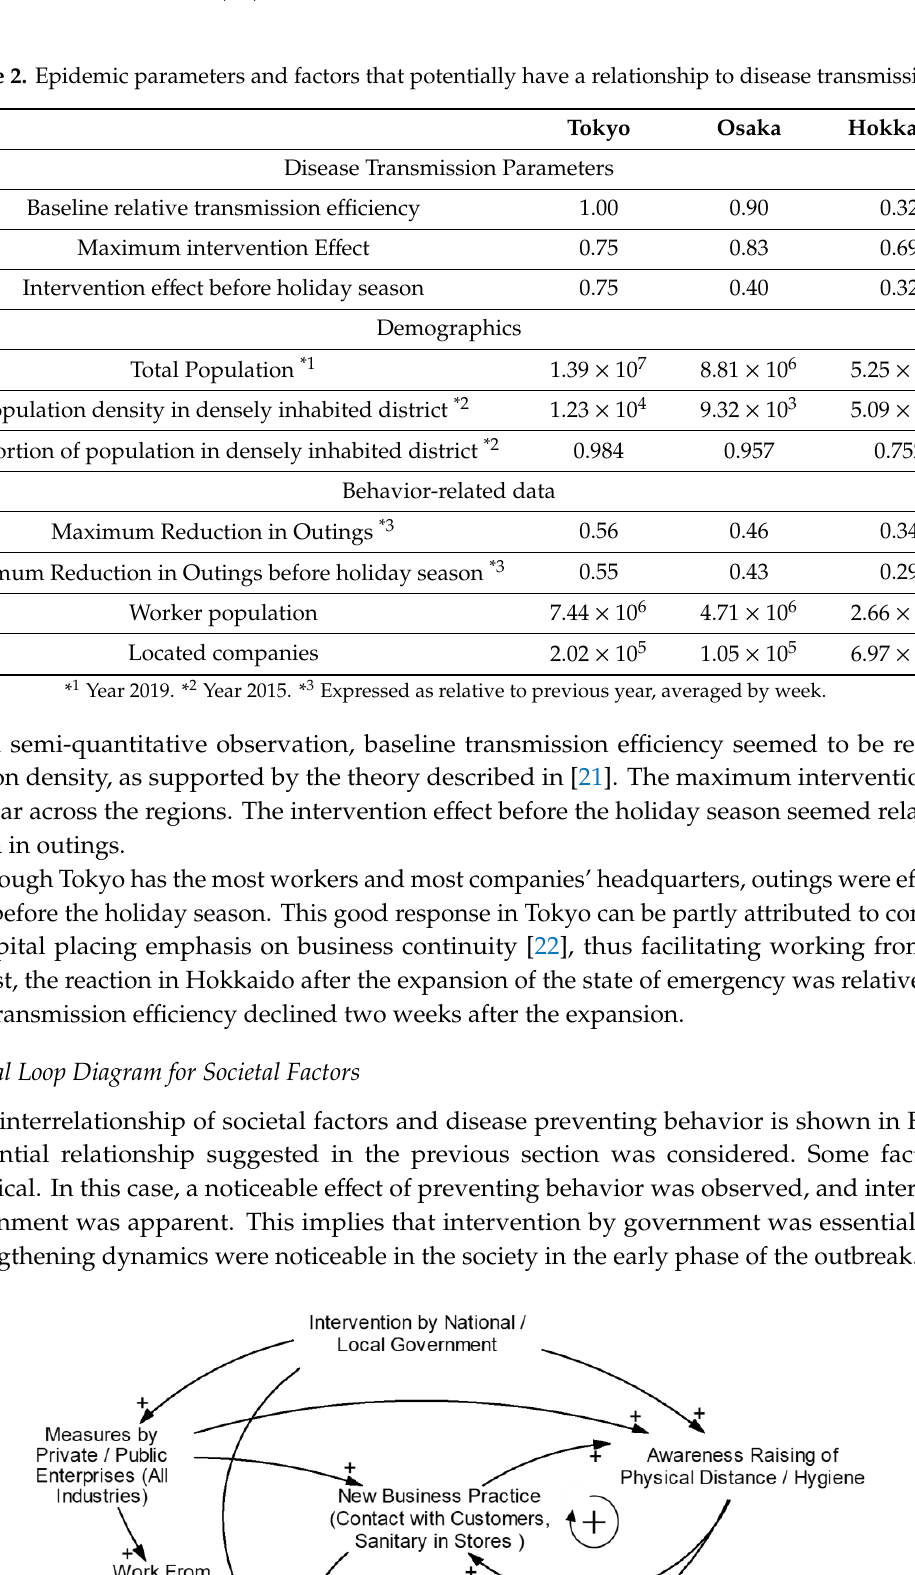
Table 2. Epidemic parameters and factors that potentially have a relationship to disease transmission.